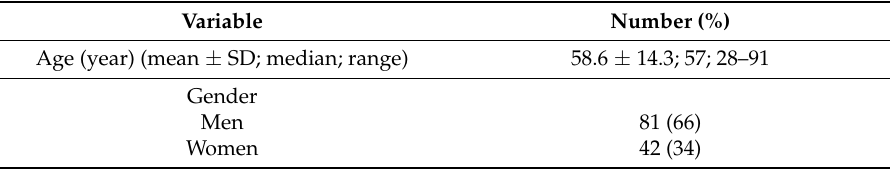
Table 1. Clinical and pathological characteristics of 123 patients with oral squamous cell carcinoma and where zinc finger AN1-type containing 4 (ZFAND4) was